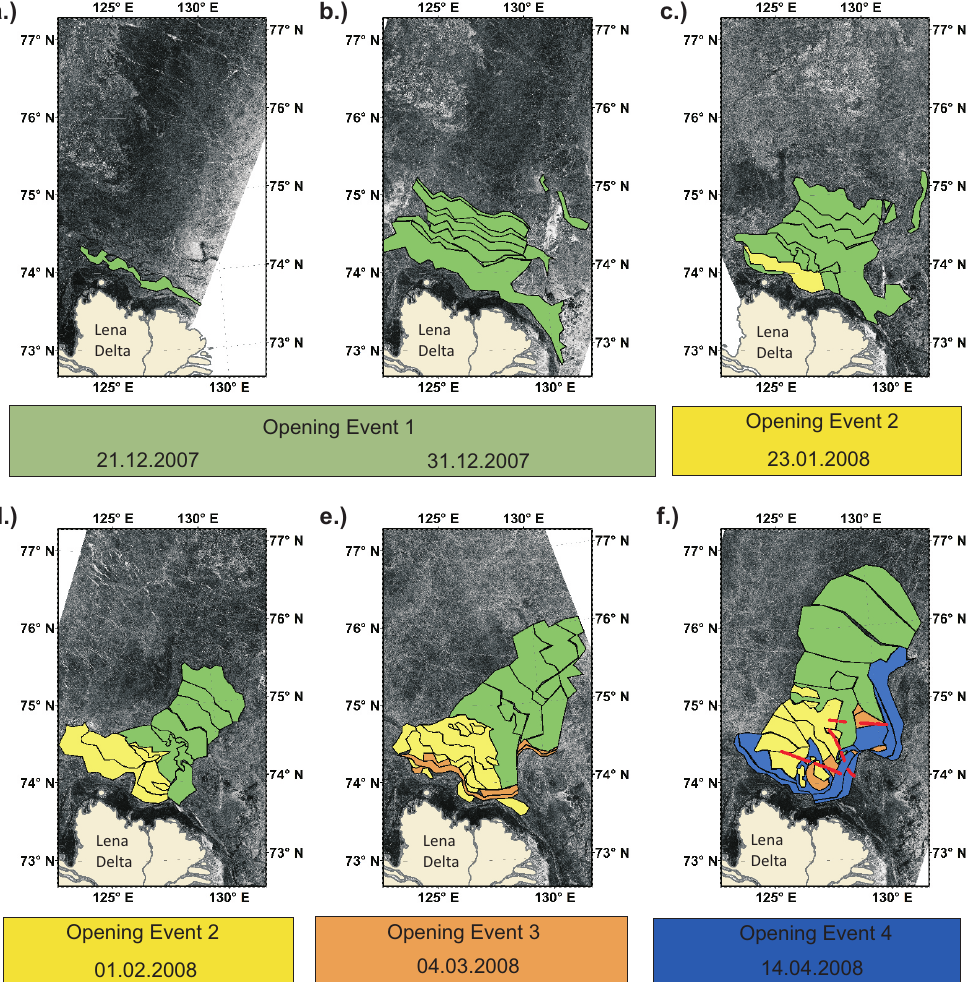
Fig. 3. Snapshots of sea-ice tracking on SAR satellite images. Areas contain sea ice formed after polynya opening events along the fast ice edge between 21 December 2007 and 14 April 2008: green – event 1 (December), yellow – event 2 (January), orange – event 3 (March), and blue – event 4 (April). Red lines in (f) are HEM sea-ice thickness profiles